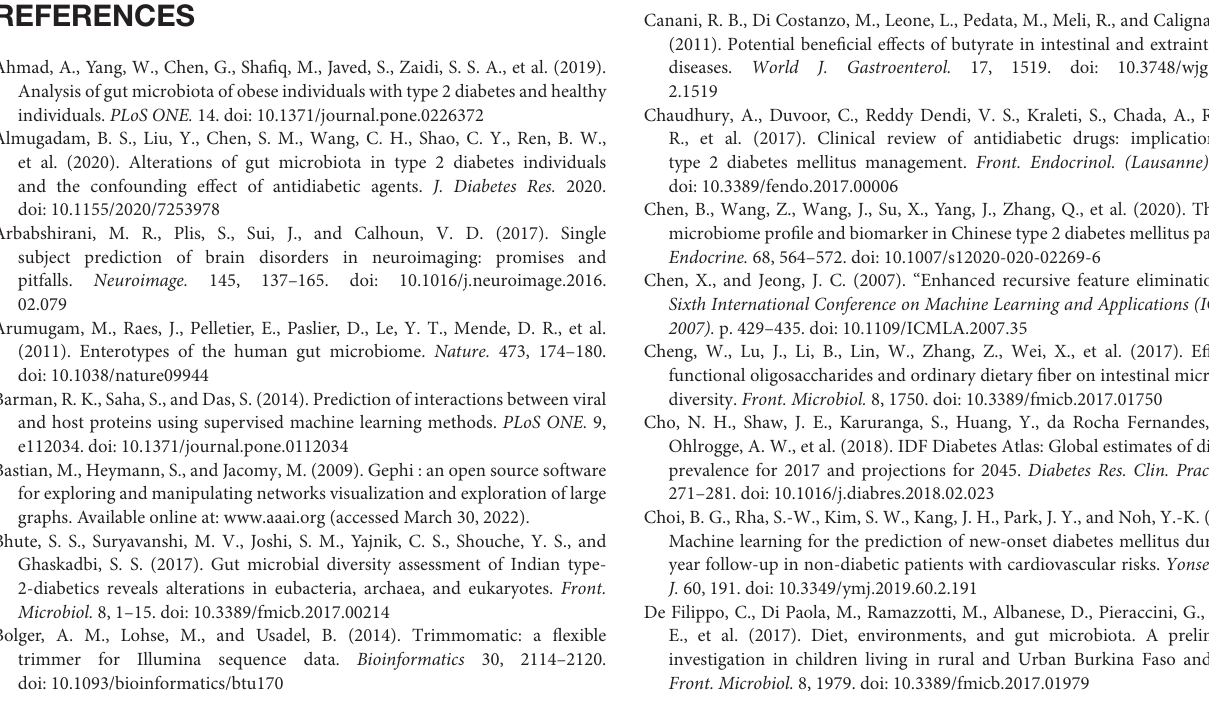
Supplementary Table S2 | Step by step sequence processing information.